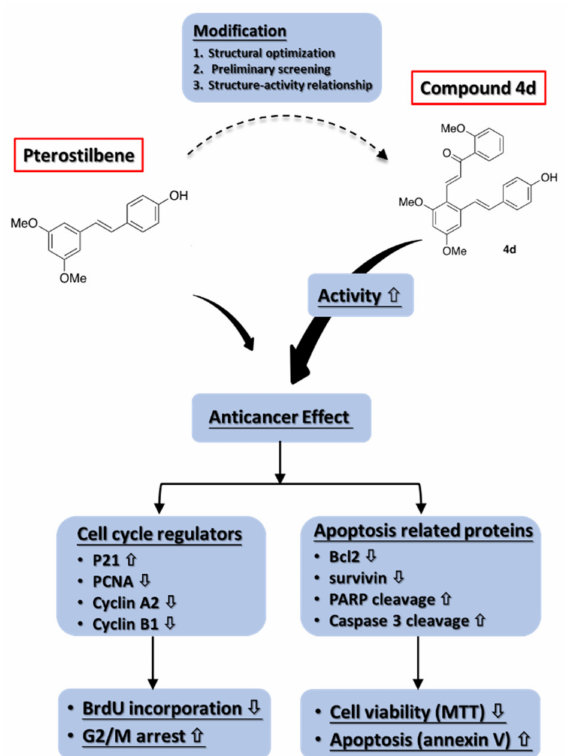
Figure 9. Schematic representation of the mechanism of compound 4d in anticancer activity. Supplementary Materials: The following are available, NMR spectra of each tested